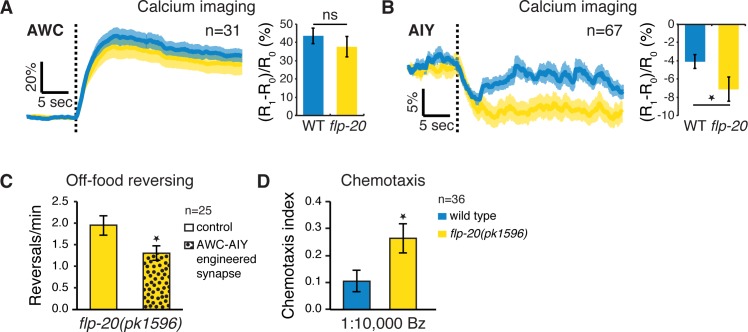
FLP-20 modifies AWC→AIY transmission regulating Bz chemotaxis.(A,B) Averaged trace (left) and mean ratio change (right) before and after Bz removal (dotted line) recorded in AWC (A) and AIY (B) neurons in wild type and flp-20 mutants. The unchanged AWC response and the enhanced AIY response are similar to those of mec-4 (Fig 2C and 2E). (C) An engineered electrical synapse inserted between AWC and AIY counteracts the increased reversing rate of flp-20 mutants. (D) Chemotaxis to 1:10,000 Bz is enhanced in the absence of functional FLP-20. Sample size indicated in each panel; Error bars represent SEMs; *p < 0.05 t test.